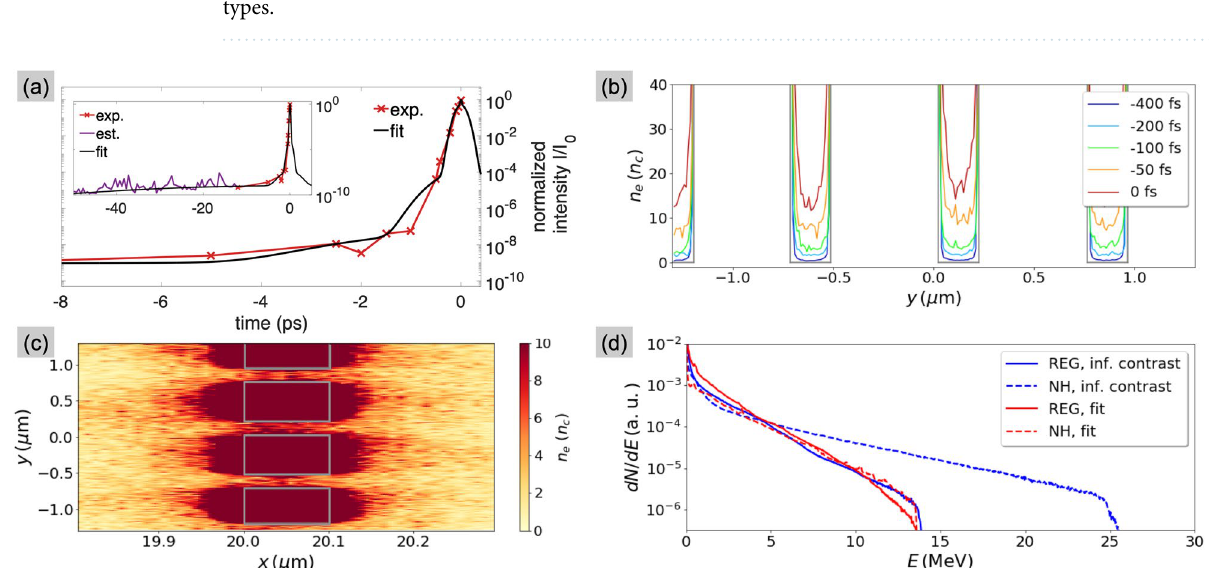
Figure 6. Results of the PIC simulations with finite contrast. ( a ) Profile of the laser pulse that fits the cross- correlator trace. The entire simulation setup is described in Methods. ( b ) Evolution of the plasma density inside the NHs at different times before the peak of the pulse (fixed at t the density maps along the whole target thickness. An example of density map, taken at where the grey boxes highlight the original target shape. ( d ) Comparison of proton spectra from regular foil and NH target, obtained with either the infinite-contrast or with the fitted laser